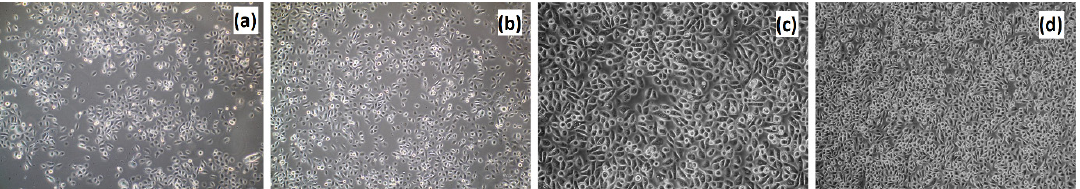
Figure 18. Control culture of VK2/E6E7 cells: ( a ) 1st passage, 5th day of the cell culture; ( b ) 1st passage, 7th day of the cell culture; ( c ) 3rd passage, 7th day of the cell culture; and ( d ) 3rd passage, 7th day of the cell culture.